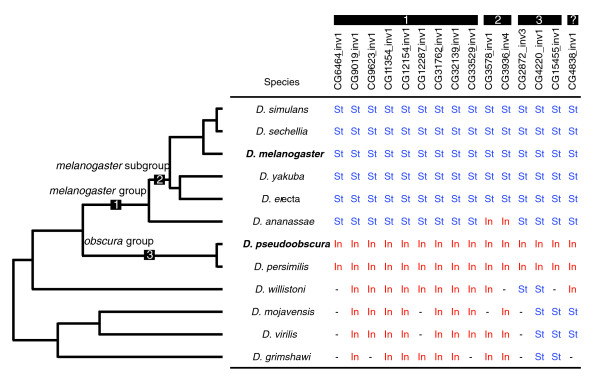
Phylogenetic distribution of fifteen microinversion events. For 15 microinversions distinguishing the genomes of D. melanogaster and D. pseudoobscura, we examined orthologous regions from 10 other Drosophila species to determine whether they harbor the standard (St; D. melanogaster-like) or inverted (In; D. pseudoobscura-like) arrangement. Some species could not be reliably shown to have either arrangement (shown with a dash). A consensus phylogeny of the 12 species is provided. The microinversion events are grouped according to phylogenetic position, and mapped onto the consensus phylogeny.